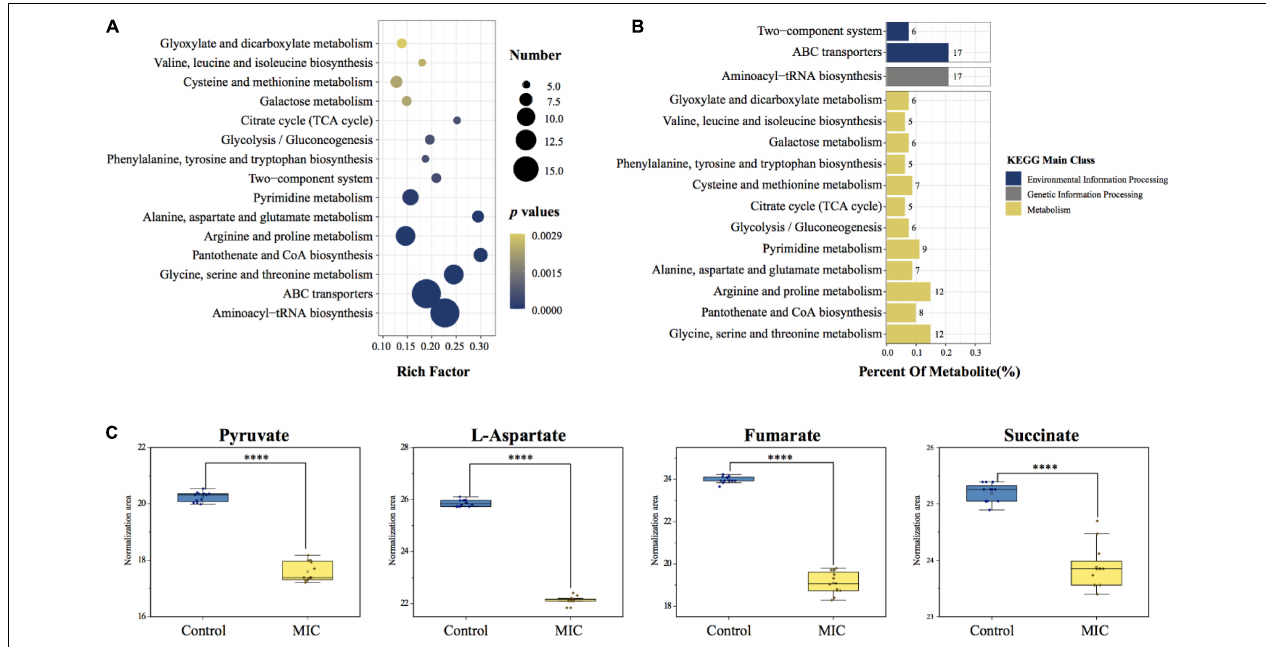
FIGURE 6 | Metabolic pathway enrichment analysis and critical metabolites involved in the pathway. (A) KEGG enrichment analysis bubble chart of metabolic pathways. The x-axis represented the rich factor (the number of differential metabolites enriched in the pathway). The y-axis represented the name of KEGG pathways. The size of the bubble represented the number of the differential metabolites, and the color represented p -values. (B) KEGG classification of enriched pathways. The number next to the bar represented the number of differential metabolites involved in the pathway. (Percent Of Metabolite: the proportion of differential metabolites involved in this pathway to the total differential metabolites.) (C) Changes in the abundance of critical metabolites before and after